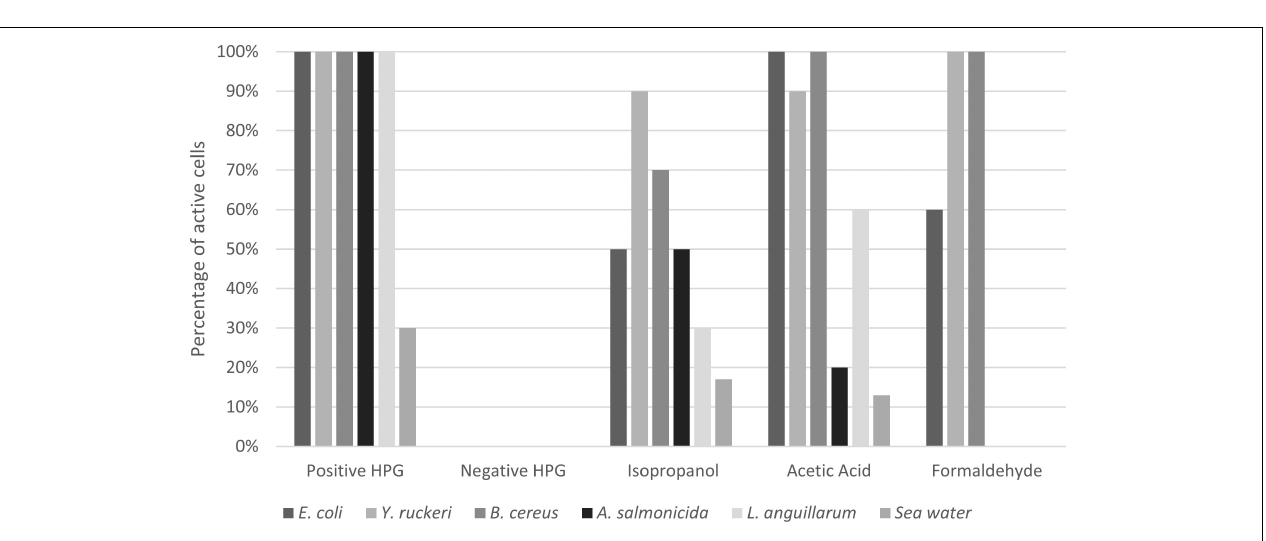
activity and gene expression (Ayrapetyan and Oliver,